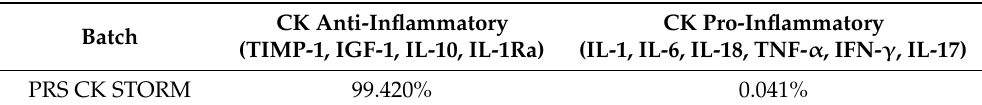
Table 4. Batch of PRS CK STORM anti-inflammatory (data expressed as the sum of the percentages representing the sum of the amounts of each of the named cytokines in pg/mL with respect to the total sum of all the cytokines studied in their composition).